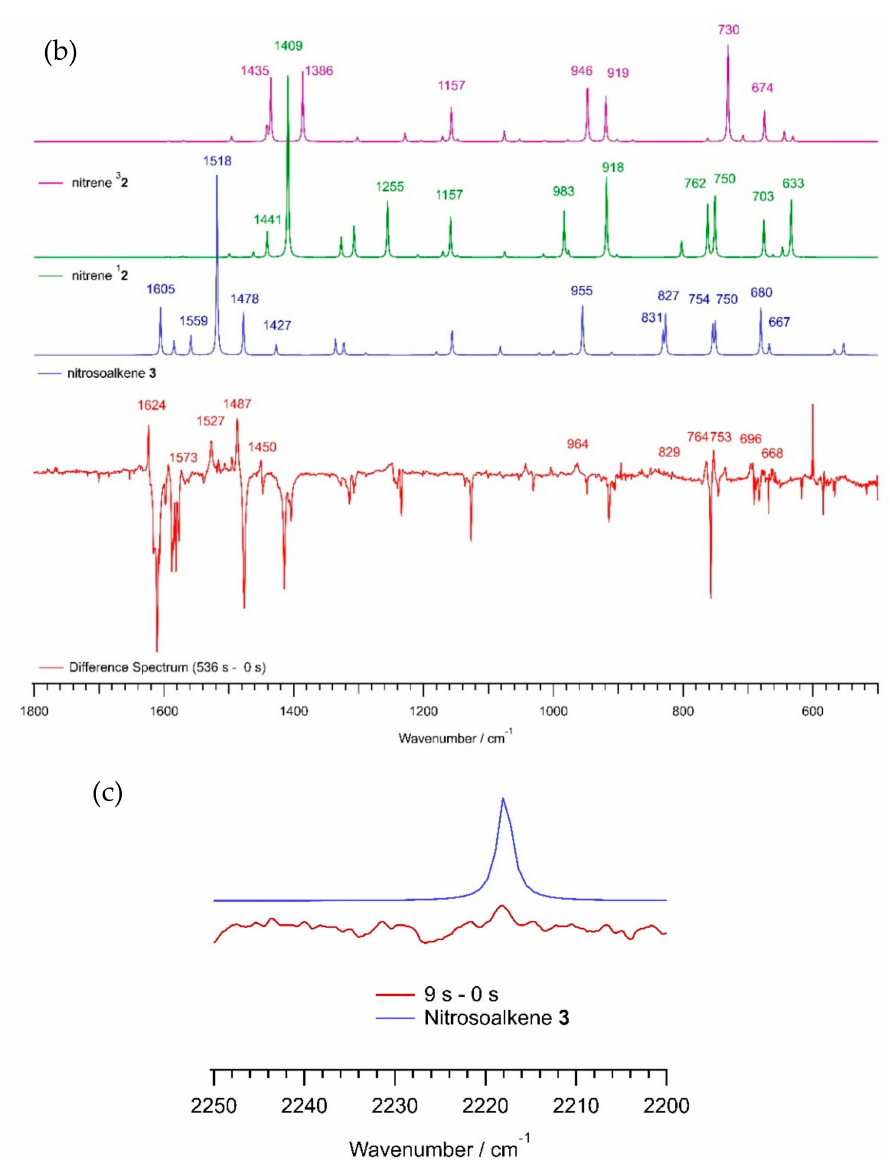
Figure 1. ( a ) Experimental IR spectra as a function of irradiation time ( λ = 254 nm) of azidoisoxazole 1 in an argon matrix; ( b ) IR spectra of nitrenes 3 2 and 1 2 and nitrosoalkene 3 calculated using B3LYP / 6-31 + G(d) [14] theory and matrix IR di ff erence spectrum (536–0 s); ( c ) Comparison of matrix IR di ff erence spectrum (536–0 s) with calculated scaled IR spectrum of nitrosoalkene 3